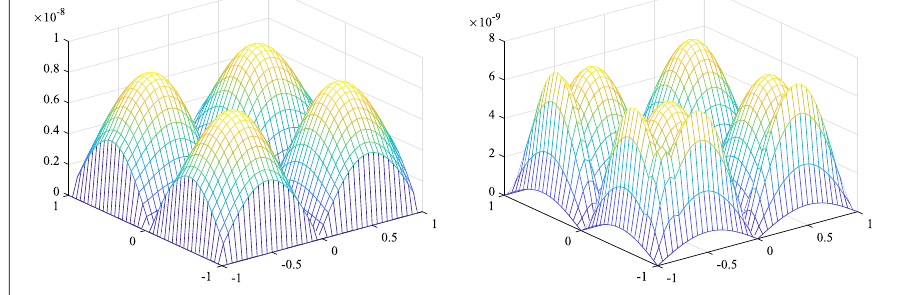
Figure 16 The error of CFDS6-SSM (left-hand side) and E-CFDS6-SSM (right-hand side) when J = 41, z = –0.4 and t = 1 for SP 5